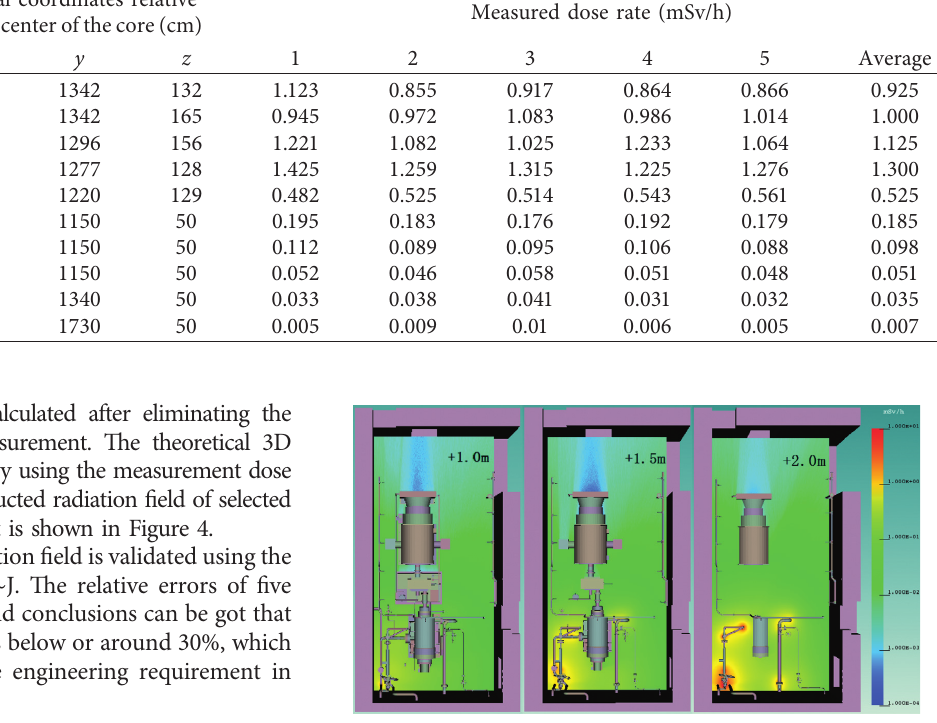
Figure 4: Reconstructed 3D radiation field of the selected typical radiological compartment. Table 2: Error analysis of reconstructed 3D radiation field.